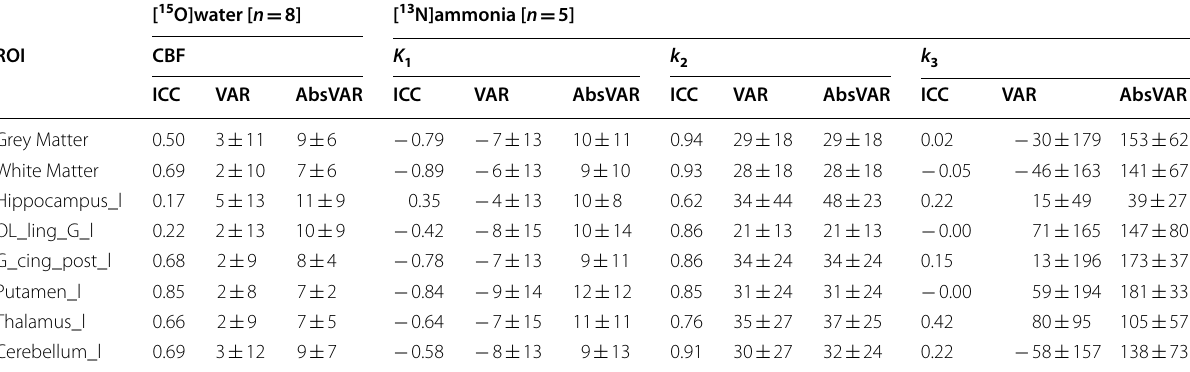
The table presents the intraclass correlation coefficient (ICC), percent mean fractional difference (VAR) and percent absolute fractional difference (AbsVAR) across test and retest scans. Data are presented as mean standard deviation for grey matter, white matter and the left (l) hippocampus, lingual gyrus (OL_ling_G), posterior ± cingulate gyrus (G_cing_post), putamen, thalamus, and